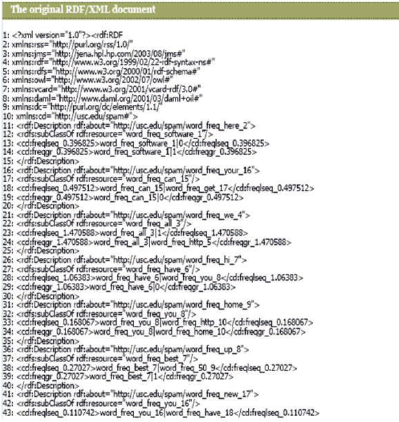
Figure 3: Converted RDF file of C4.5 classification result.